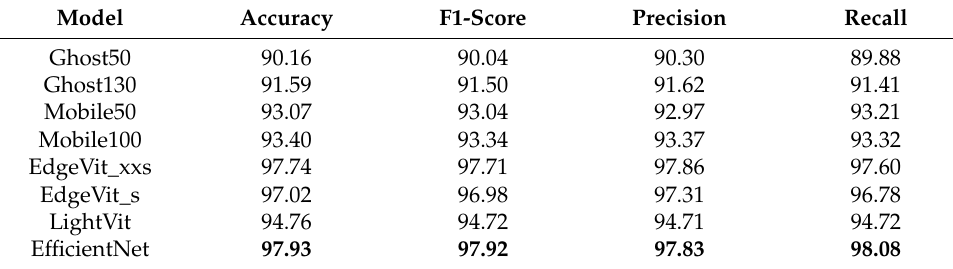
Table 4. Classification performance comparison results